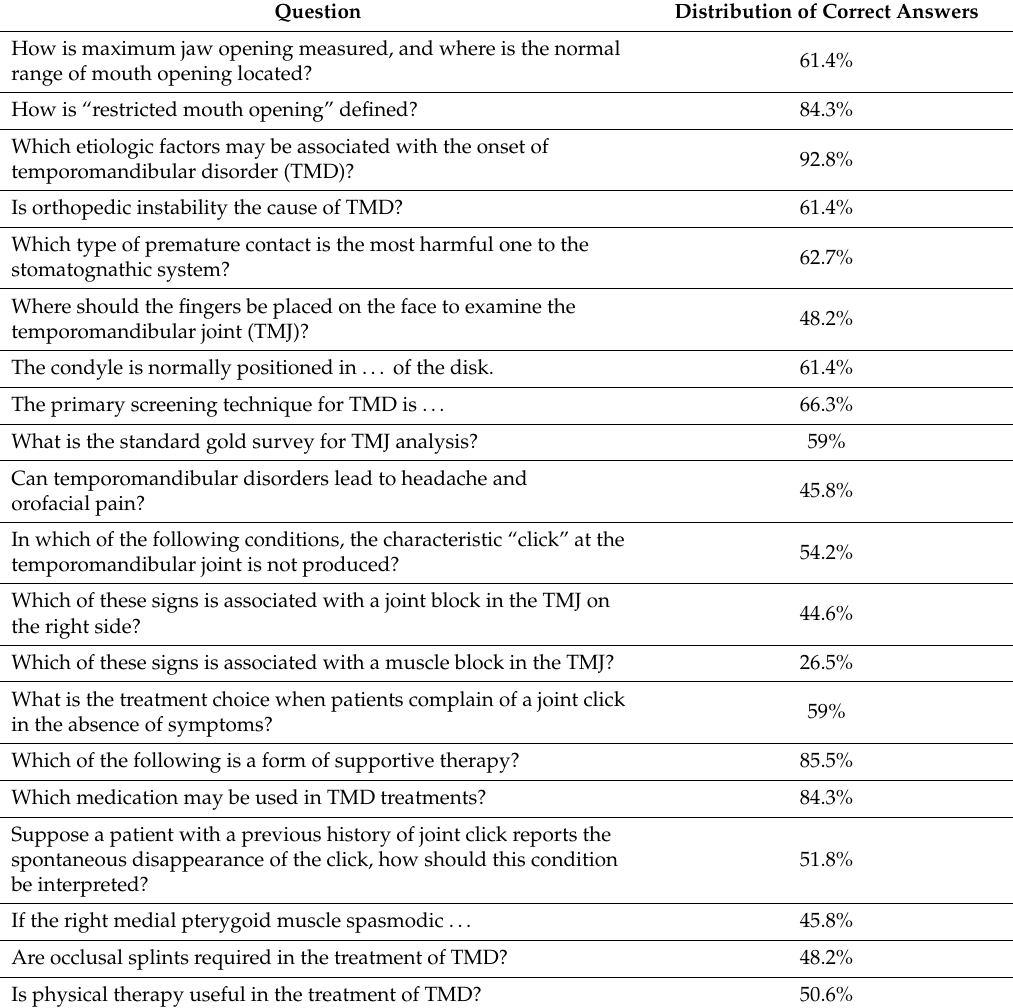
Table 2. Distribution of correct